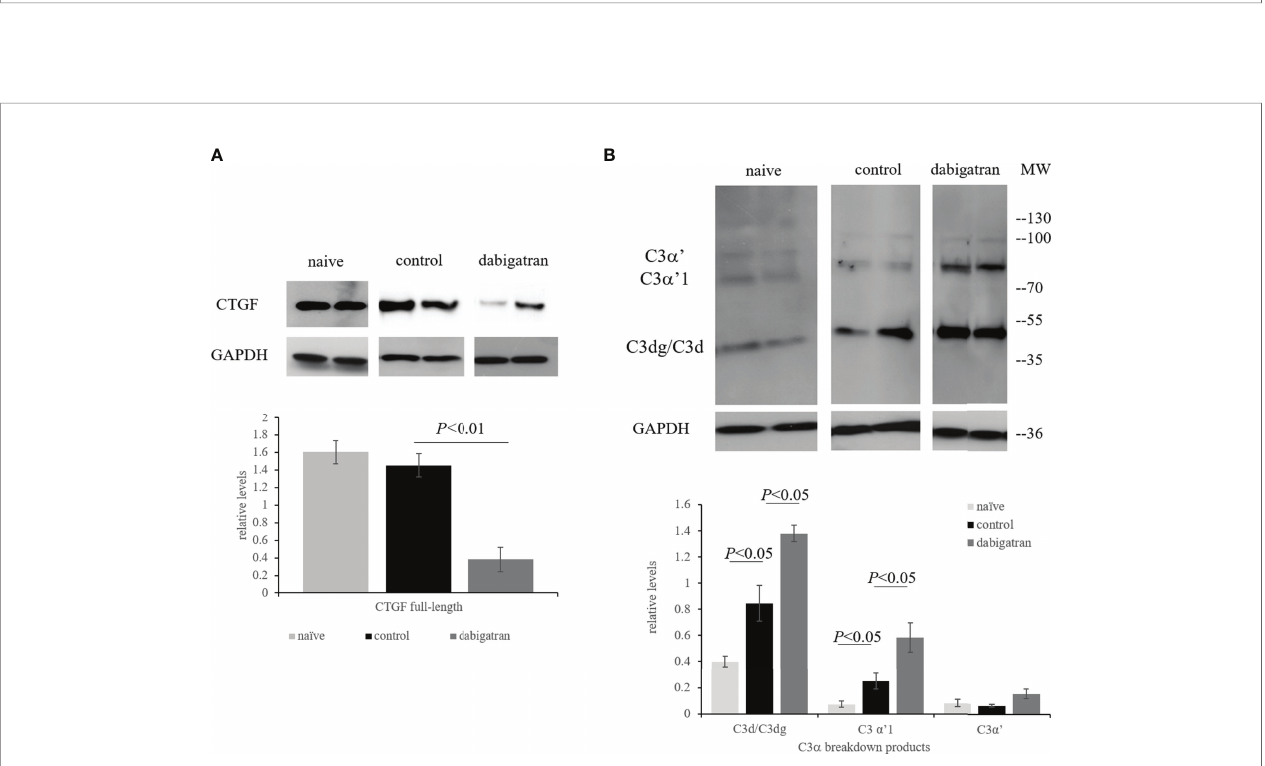
FIGURE 8 | In repair phase of CNV, dabigatran reduces CTGF expression. Western blot analysis was performed as described in legend for Figure 7 . (A) Dabigatran reduced CTGF in the wound healing paradigm when compared to the control-treated and naïve animals. (B) Complement activation was increased in RPE/choroid of CNV animals when compared to naïve animals. Surprisingly, complement activation was further increased by treatment when compared to PBS controls. Data are expressed as mean ± SEM (n = 3-5 independent samples per